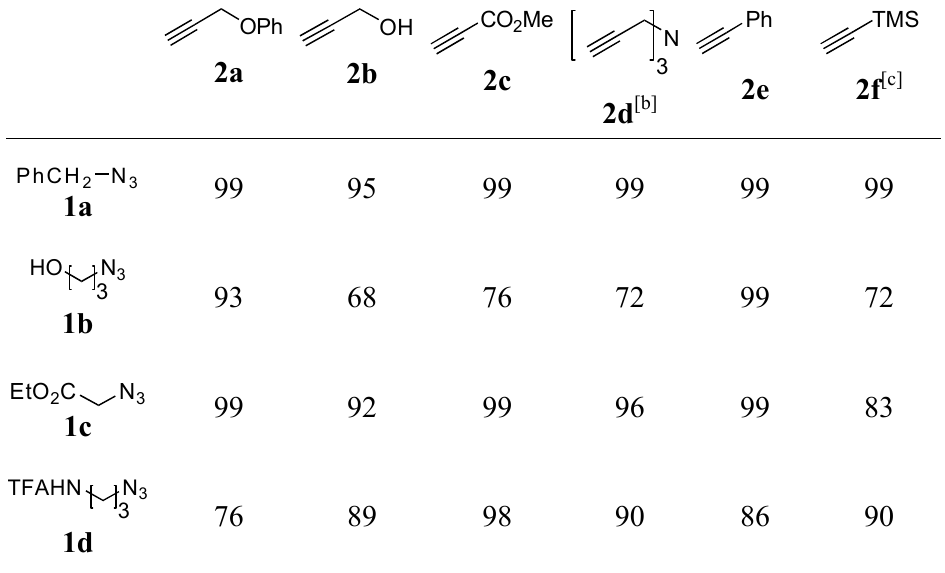
Table 1 . Yields for the solvent-free synthesis of a series of triazoles a .